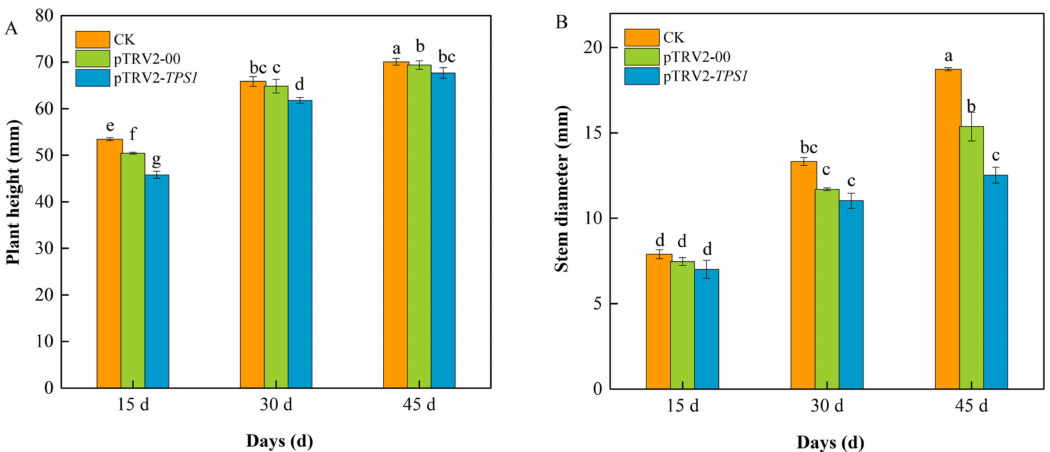
Figure 3. Changes in plant growth after infection. Plant height ( A ), stem diameter ( B ) of CK, pTRV2-00, and pTRV2- CaTPS1 at 15 d, 30 d, and 45 d after inoculation. Each value is shown as the mean ± standard error of three biological replicates, and the multiple comparison test for each gene was presented. Different letters stand for significant differences between CK, TRV2-00, and TRV2- CaTPS1 plants (Duncan’s test, p < 0.05).